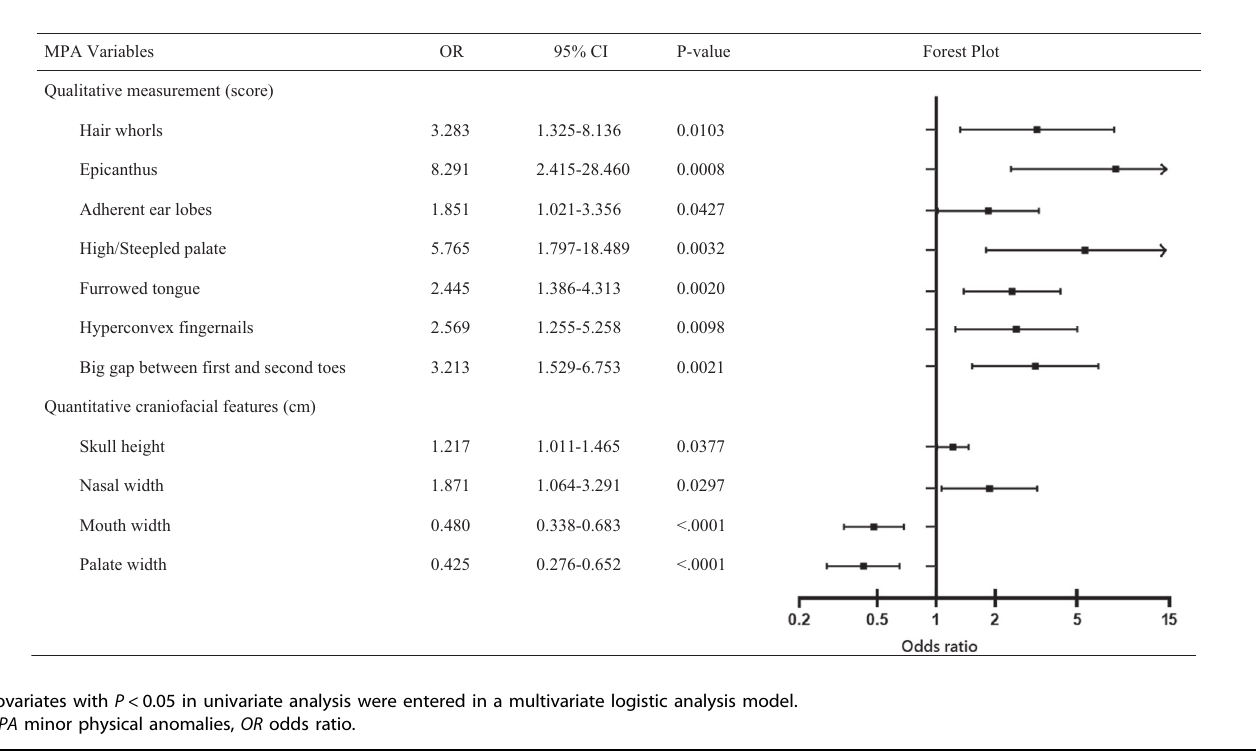
Table 2. Results of a multivariable logistic regression model on MPA of schizophrenia.